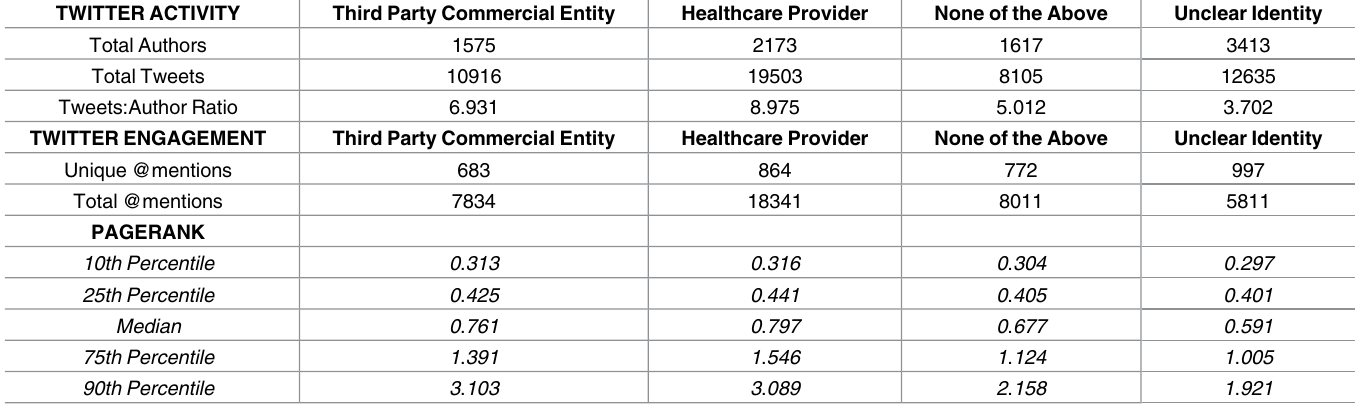
Table 4. Measuresof Twitter Activity and